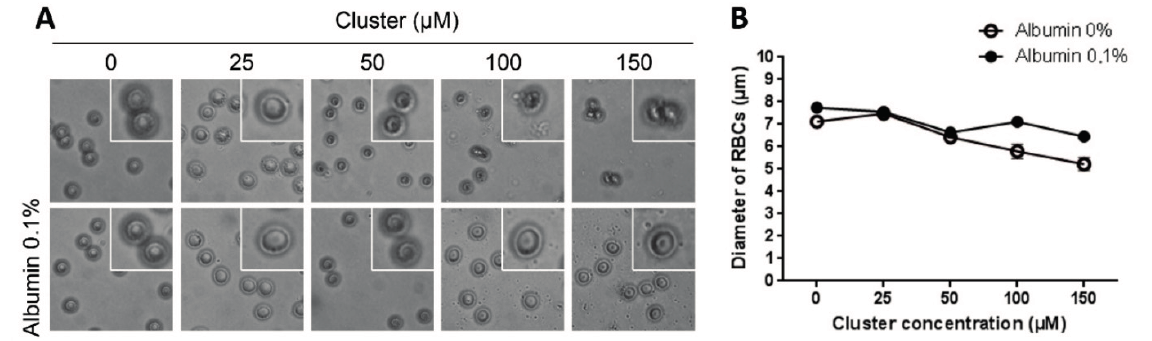
Figure 1. Acute exposition to increasing doses of the cluster did not induce hemolysis in vitro . The percentage of hemolysis after 1 h of incubation is shown. Erythrocytes suspended in distilled water were considered 100% hemolyzed. High doses of the cluster did not increase hemolysis in vitro in the presence or absence of albumin, compared to controls.